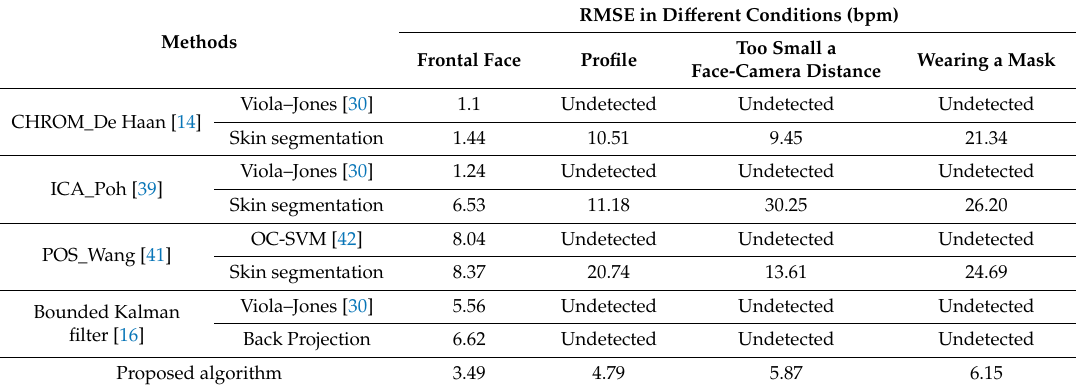
Table 9. Comparison of heart rate measured by di ff erent